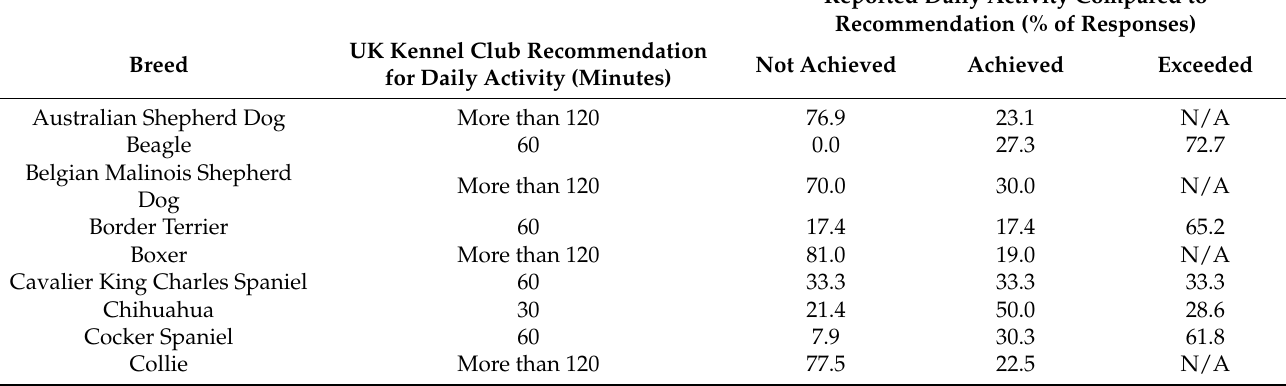
Table 3. The reported daily activity for 1713 adult dogs reported in the survey, compared to the UK Kennel Club rec- ommended daily activity levels by breed. Where the recommendation is more than 120 min per day, the “exceeded” recommendation response is not applicable